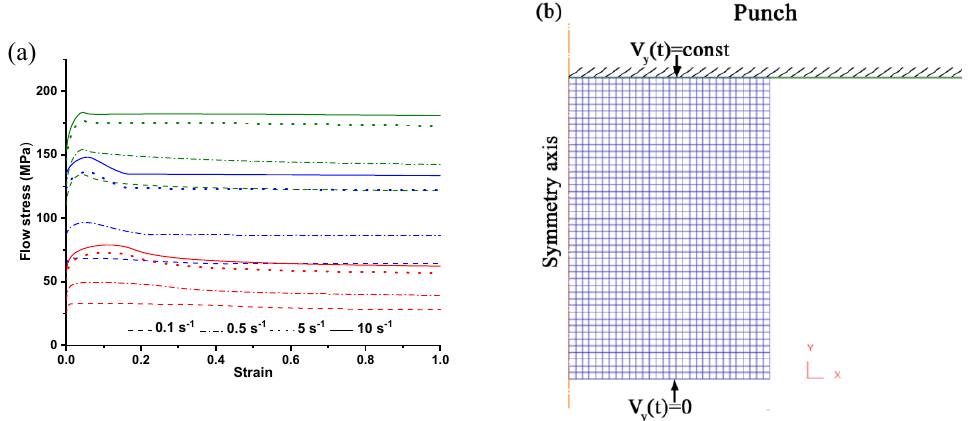
Figure 3. The dependences of flow stresses on strain ( a ) for 300 ° С (green curve), 400 ° С (blue curve), 500 ° С (red curve) and strain rates ranging between 0.1 and 10 s -1 , as well as the finite element grid used for the simulations ( b ).